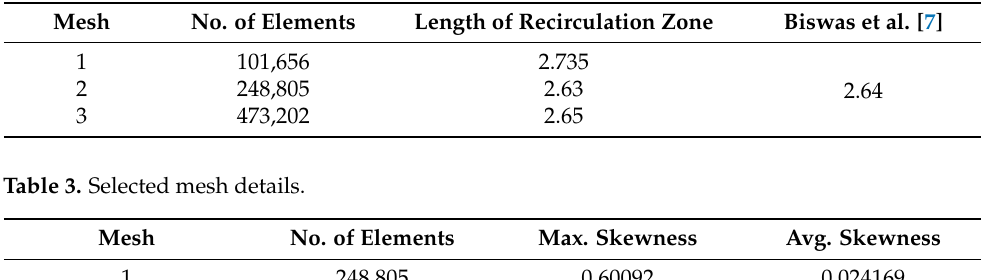
Table 2. Grid independence study at Reynolds number 100.